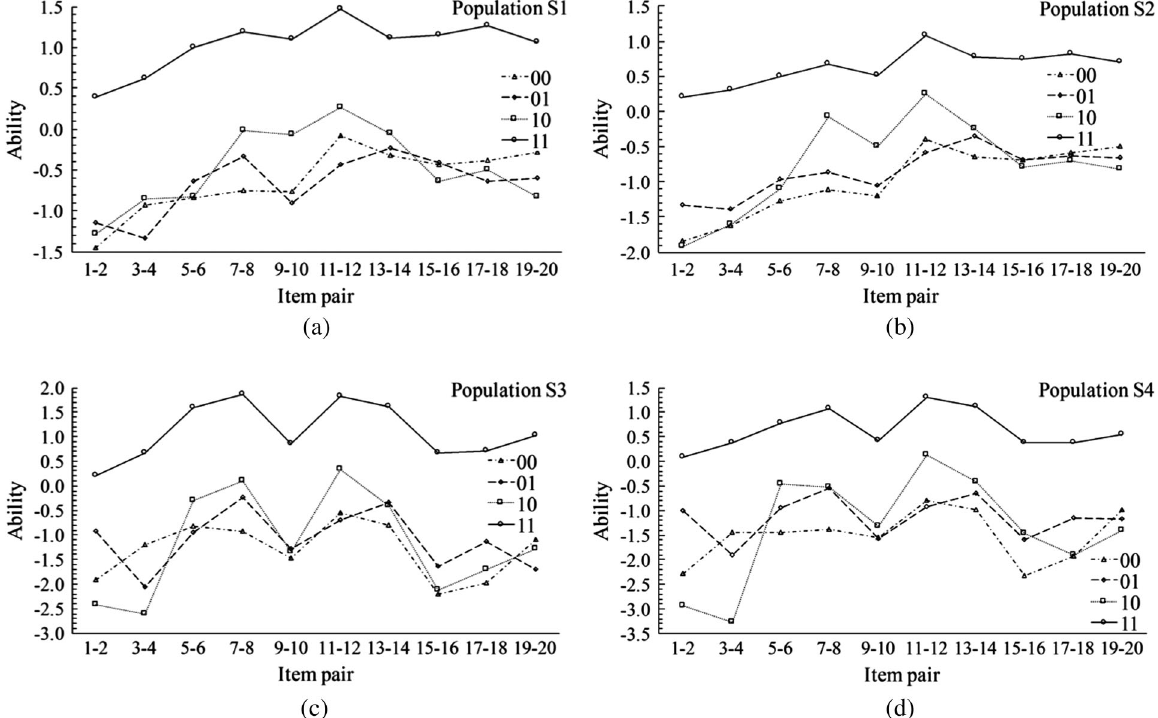
FIG. 2. Item-level average abilities of students answering with different response patterns. The students ’ abilities are estimated using M1 within each